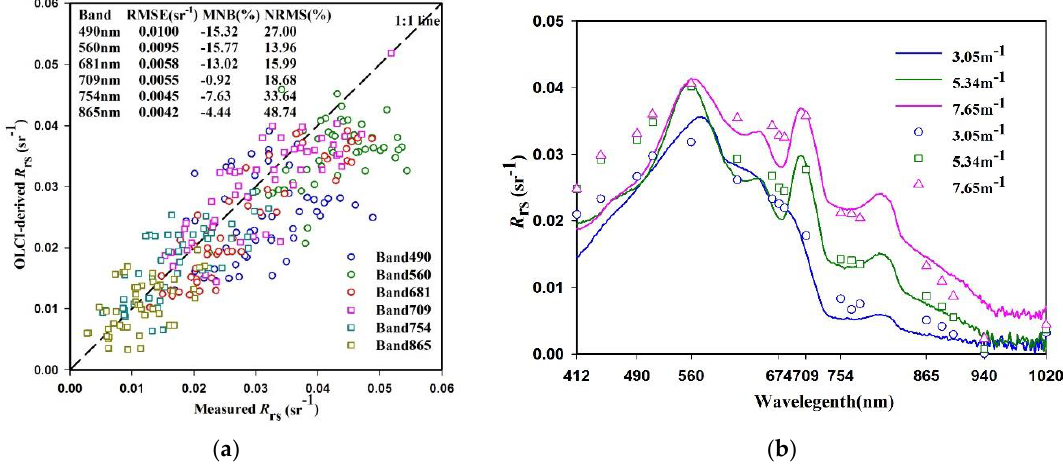
Figure 4. ( a ) Comparison of the R rs measured in situ and the OLCI-derived R rs after the 6S atmospheric correction for 40 matchups obtained in November 2016, March 2017, and April 2017; ( b ) comparison of the R rs spectrum measured in situ and the OLCI-derived R rs spectrum after the 6S atmospheric correction for different K d (490) values. The lines represent the R rs spectra from the in situ measurements, and the marks represent the OLCI-derived R rs spectra after the 6S atmospheric corrections.